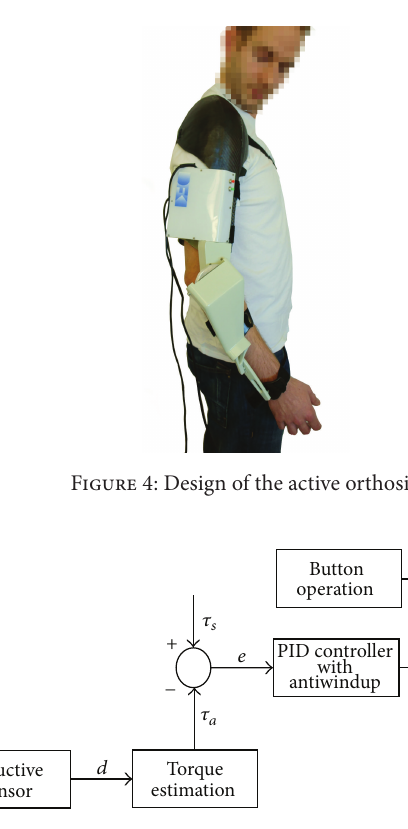
Figure 5: Block diagram of the torque control